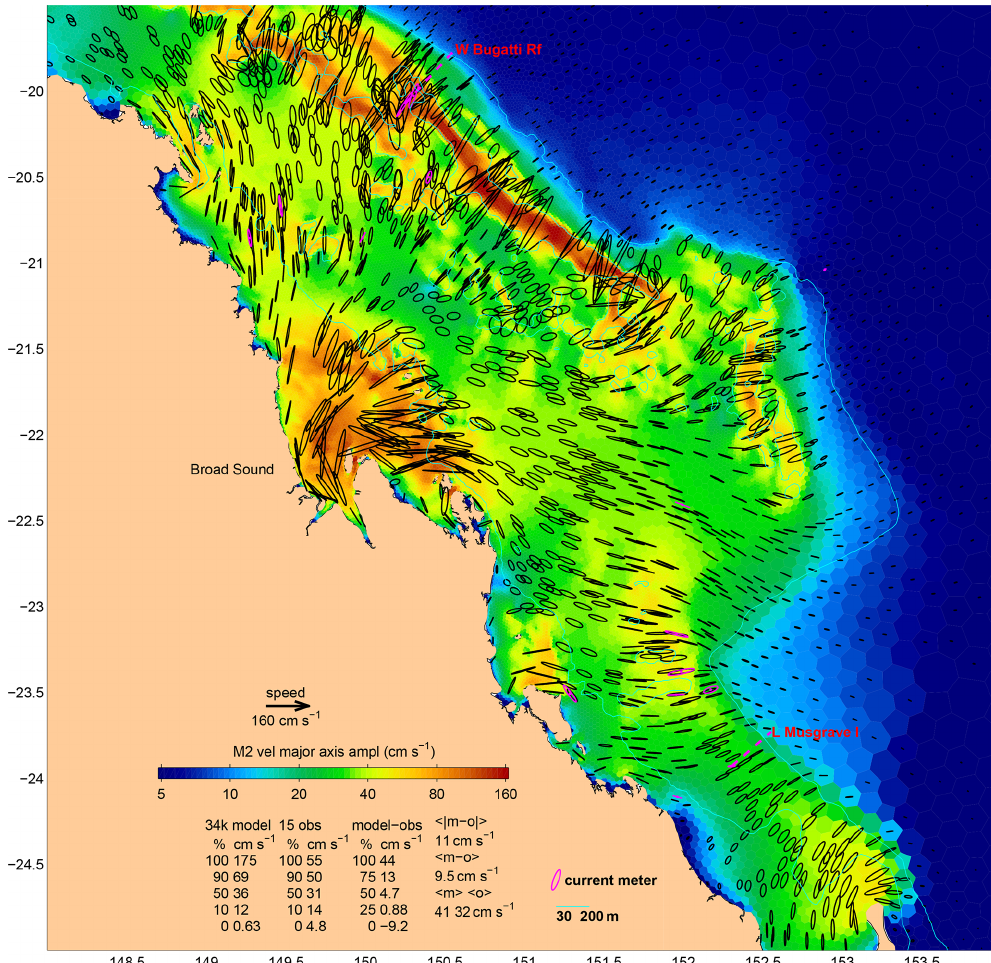
Figure 11. Amplitude of the M2 major axis velocity for the southern Great Barrier Reef region; otherwise like Fig.